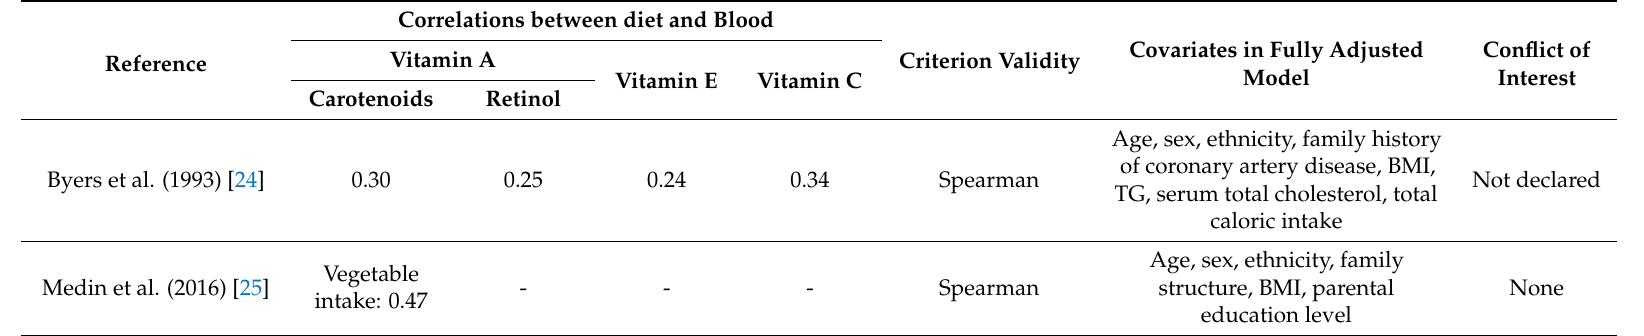
Table 4. Outcome of the included